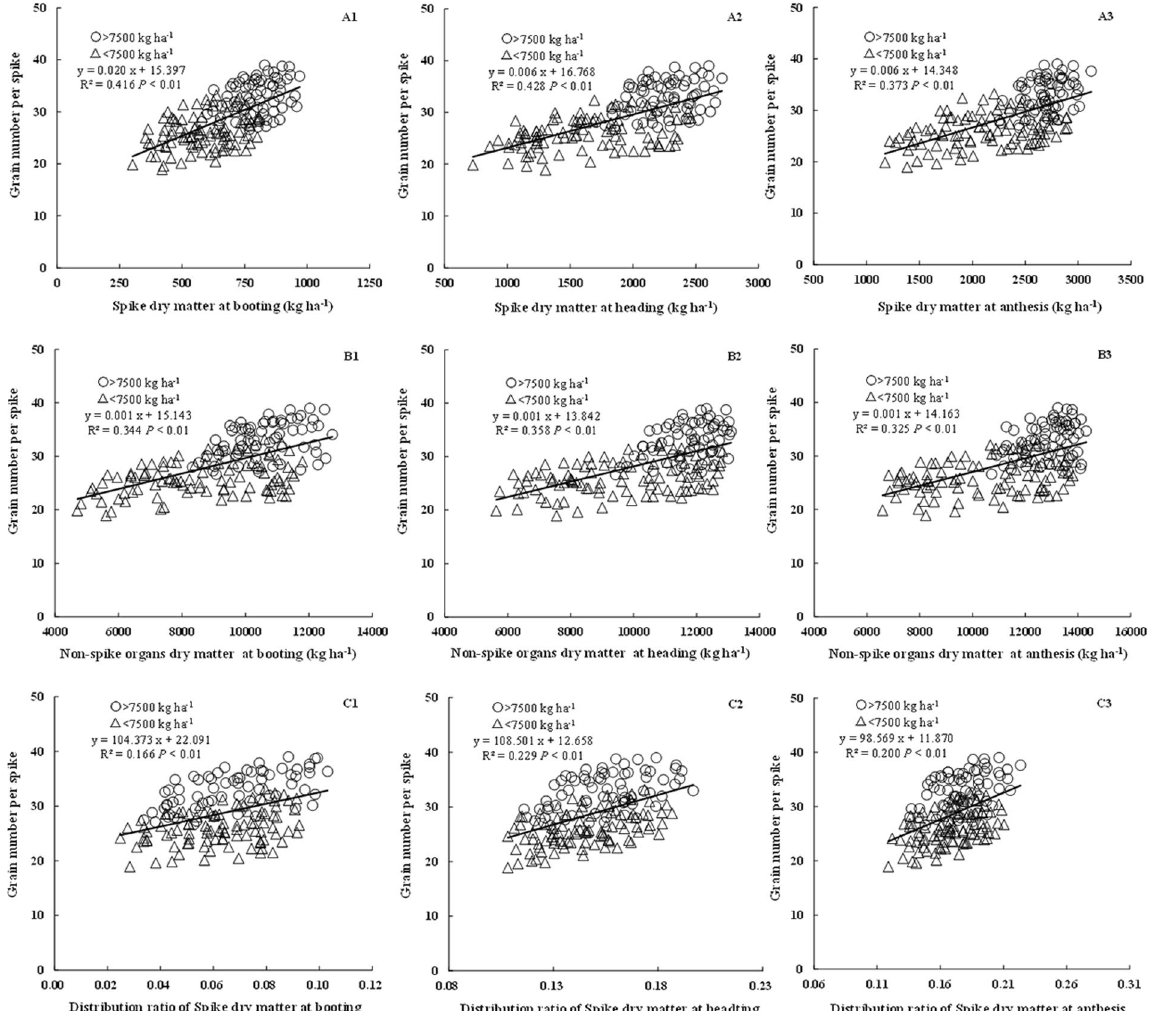
Figure 2. Relationship between grain number per spike and spike dry matter, non-spike organs dry matter and the distribution ratio of spikes in total aboveground dry matter during booting, heading and anthesis